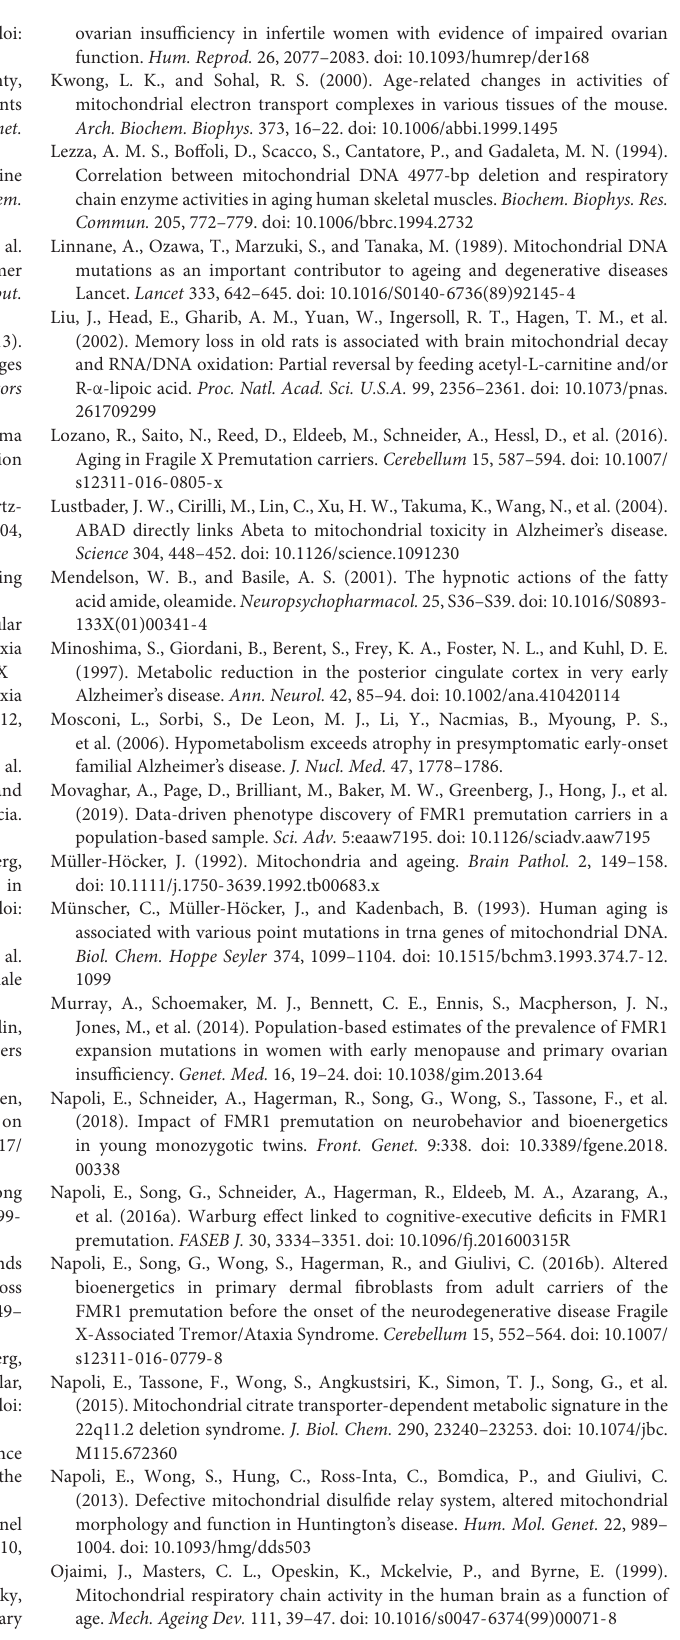
1004. doi: 10.1093/hmg/dds503 Ojaimi, J., Masters, C. L., Opeskin, K., Mckelvie, P., and Byrne, E.